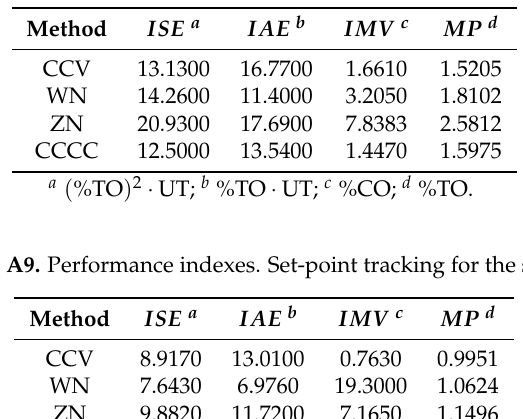
Table A8. Performance indexes. Disturbance rejection for the set P 5 .